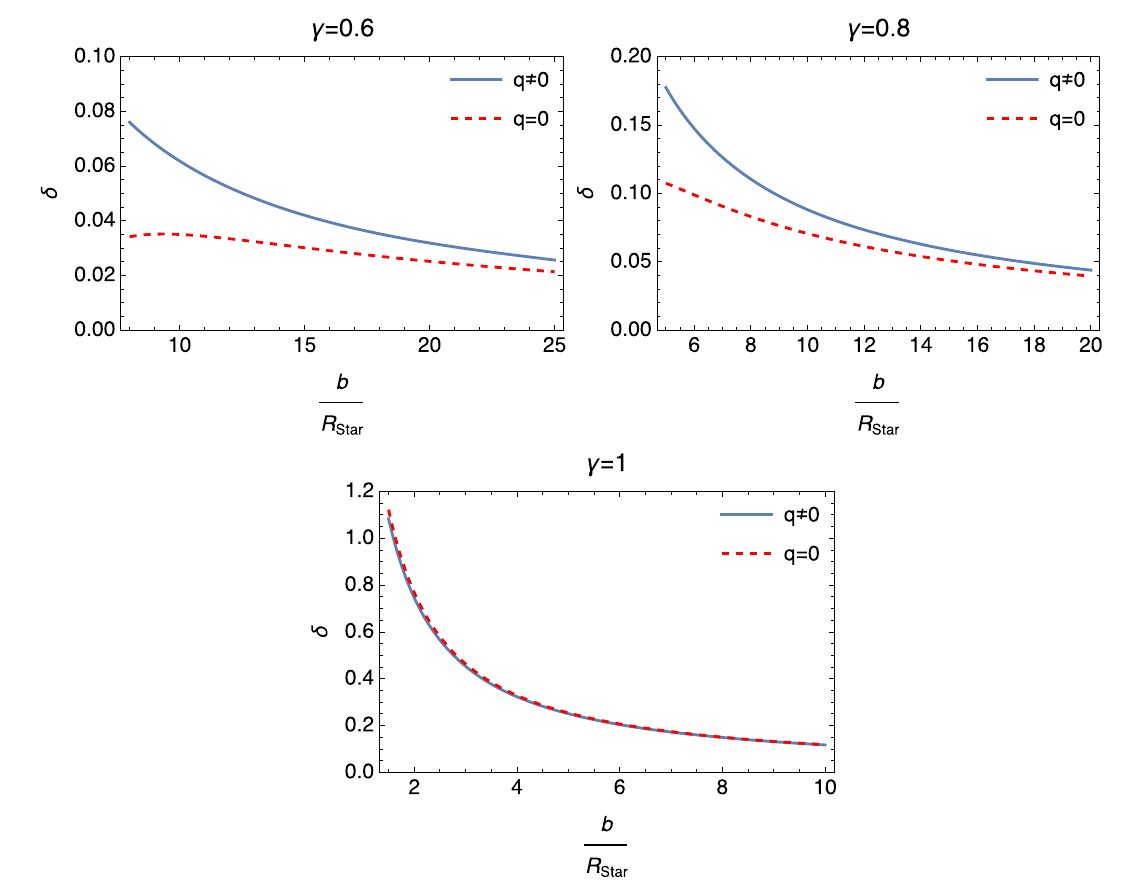
Fig. 7 δ versus x plot for the VelaX − 1 star, both charged (solid line) and uncharged (dotted line) cases for